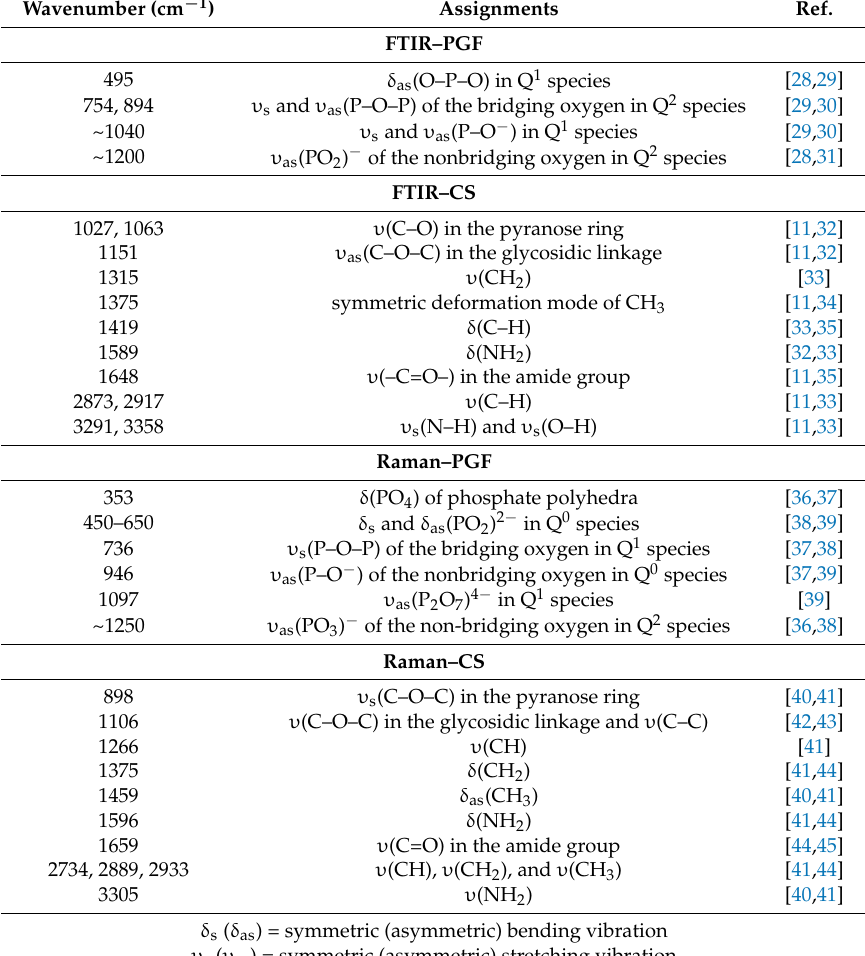
Figure 5. FTIR spectra of the CS powder used for coating (CS-P) and the “seam” on the PGFs (CS-S). Table 4. FTIR and Raman band assignments for pure PGF and CS.